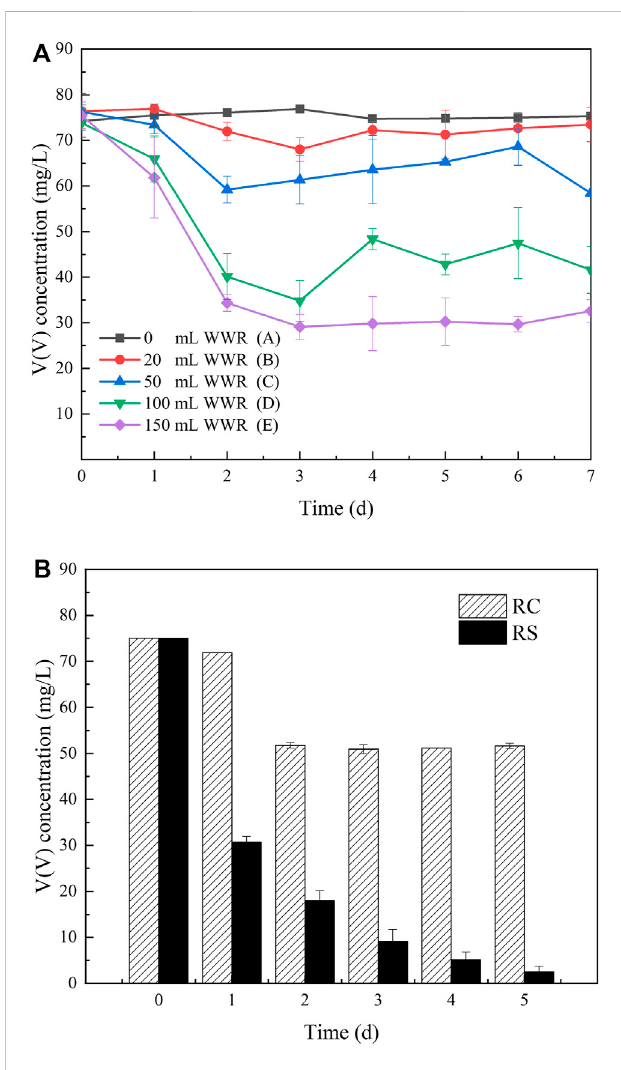
FIGURE 1 V(V) removal in various WWR dosage groups (A) . V(V) changes in un-inoculated (RC) and inoculated (RS) systems (B)